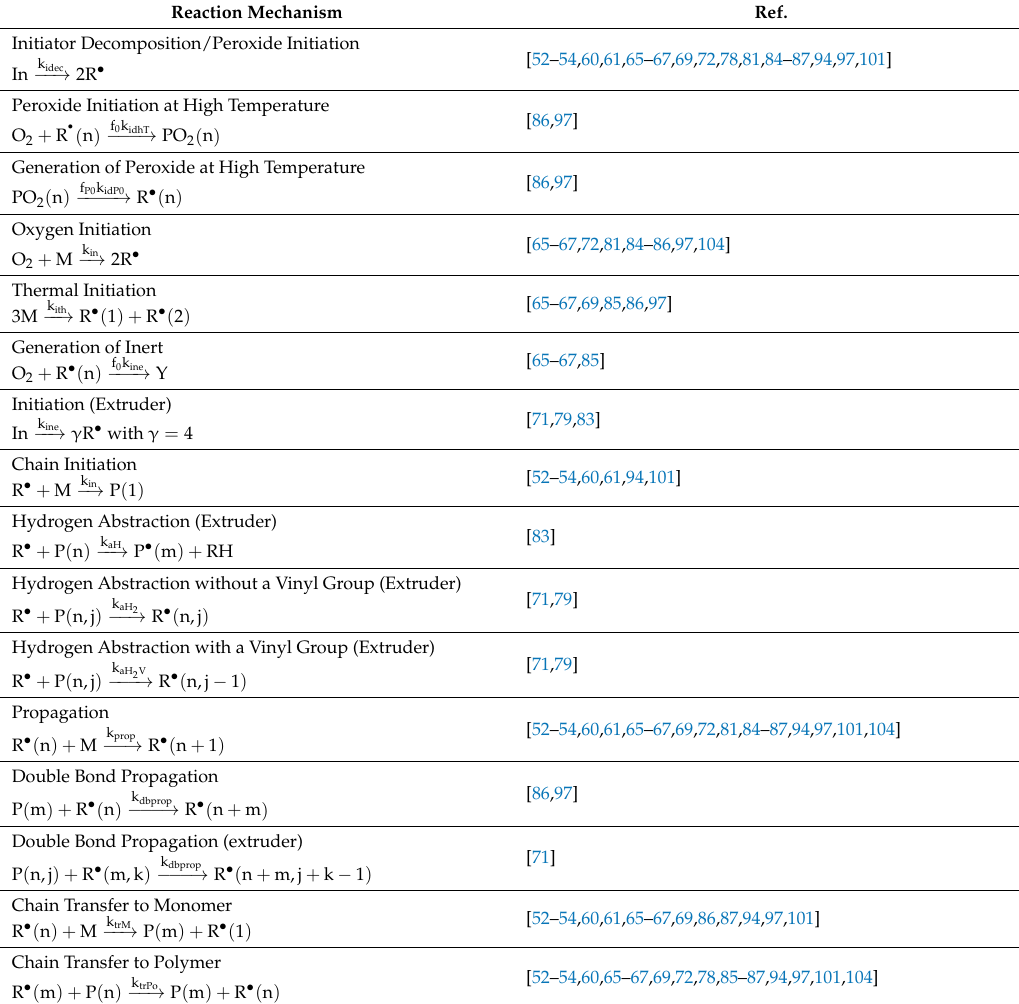
Table 4. Mechanism of the reaction for the free radical mechanism by using the organic peroxide and oxygen.